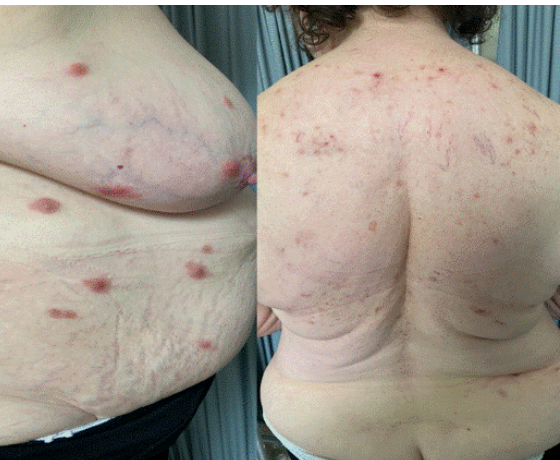
Figure 4. Erythematous plaques on the trunk, back and abdomen in a patient with acute neutrophilic dermatosis (Sweet’s syndrome) after Pfizer-BioNTech vaccine.